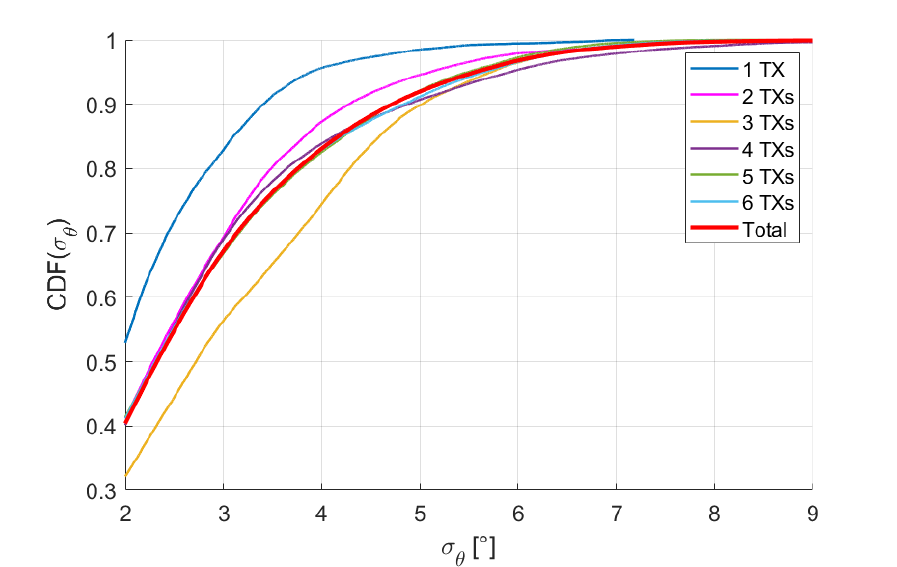
Figure 14. Cumulative distribution functions of σ θ